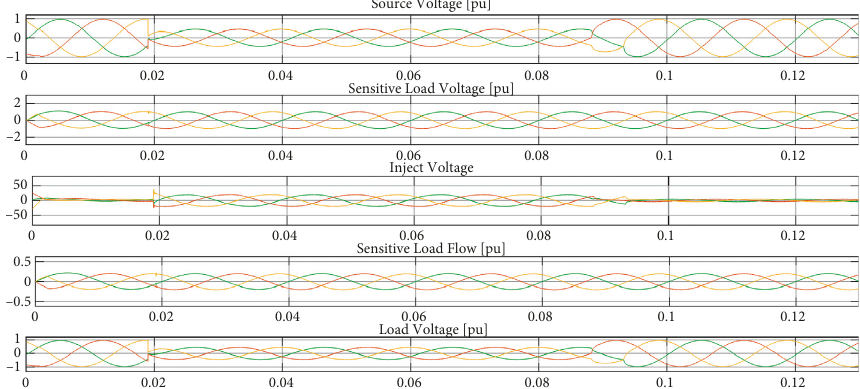
Figure 21: The result of compensating voltage sag in two-phase ground fault (by virtual comparison).